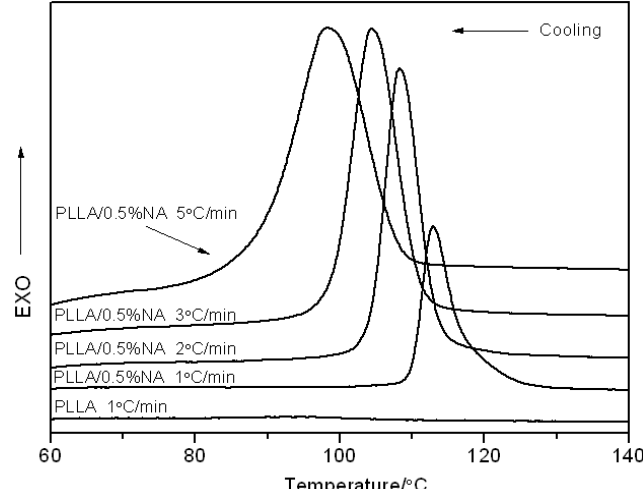
Figure 3. DSC of PLLA and PLLA/0.5%NA crystallized from melt at a different cooling